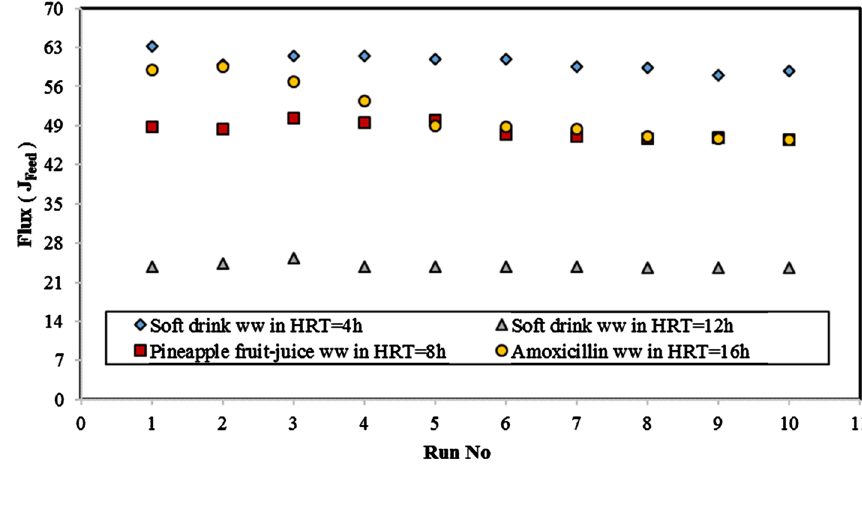
Fig. 12 The results of J during intermittent filtration of UF membrane at constant pres- sure of 30 psi for three types of